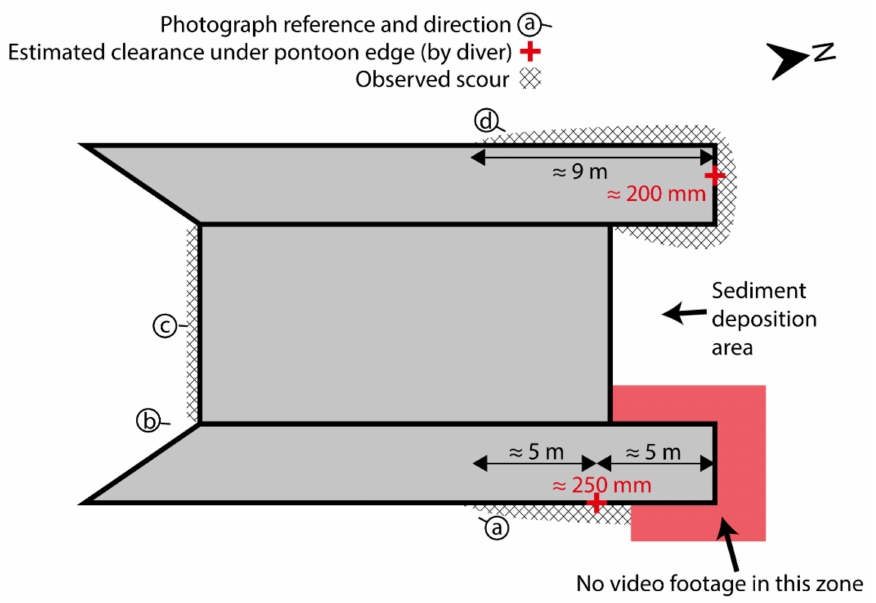
Figure 6. Plan sketch of observed scour around the OWC WEC at Location 1 on 10 January 2021. Not to